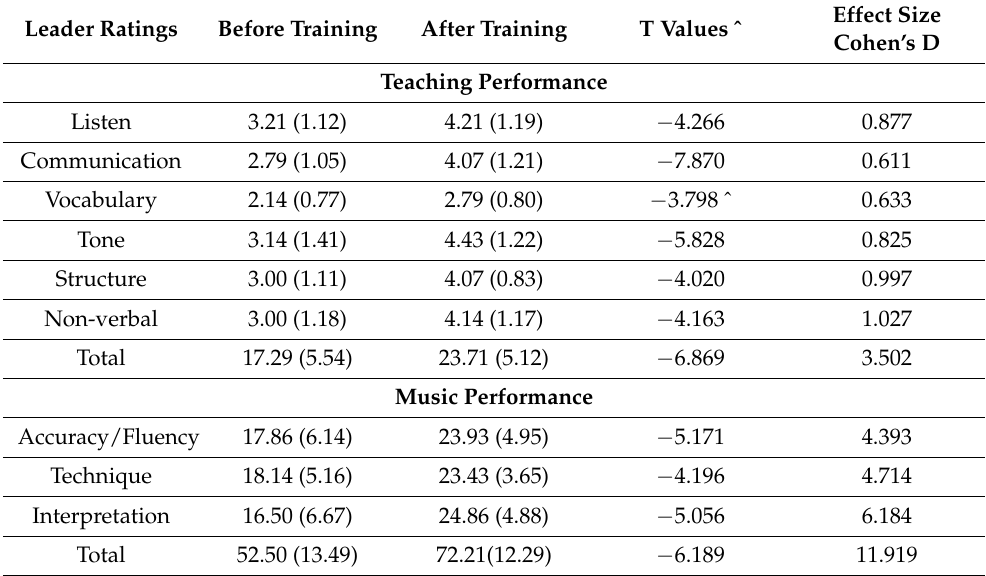
Table 1. The means (and standard deviations) of ratings given by project leaders on the mentors before and after training on teaching and music performance ( n =